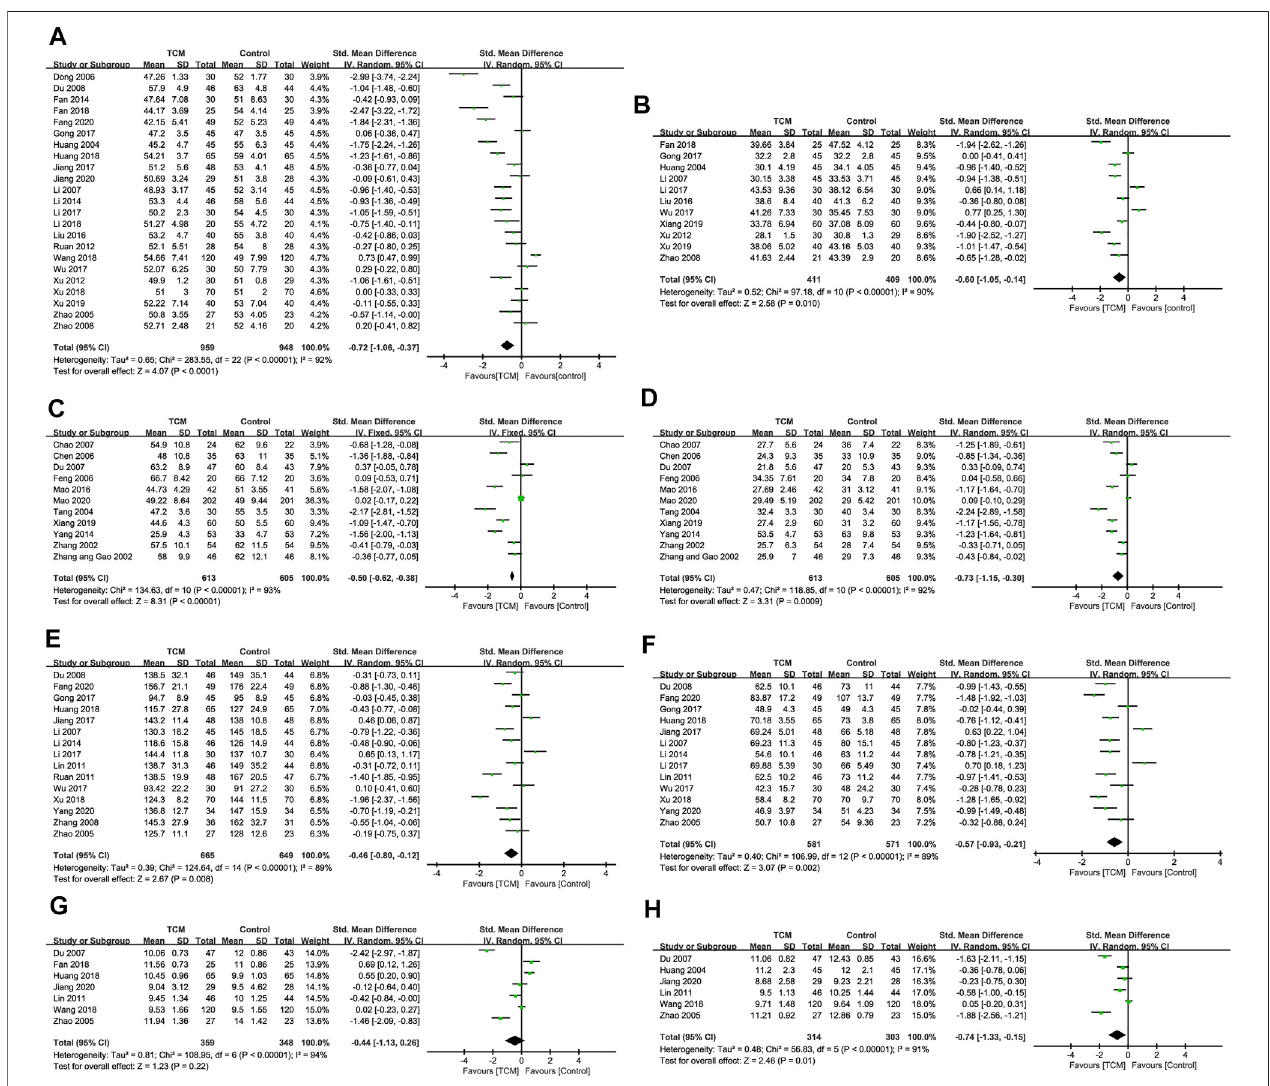
FIGURE 4 | Indicators for improving ventricular remodeling. (A) . LVEDD. (B) . LVESD. (C) . LVEDVi. (D) . LVESVi. (E) . LVEDV. (F) . LVESV. (G) . IVST. (H) . LVPWT.